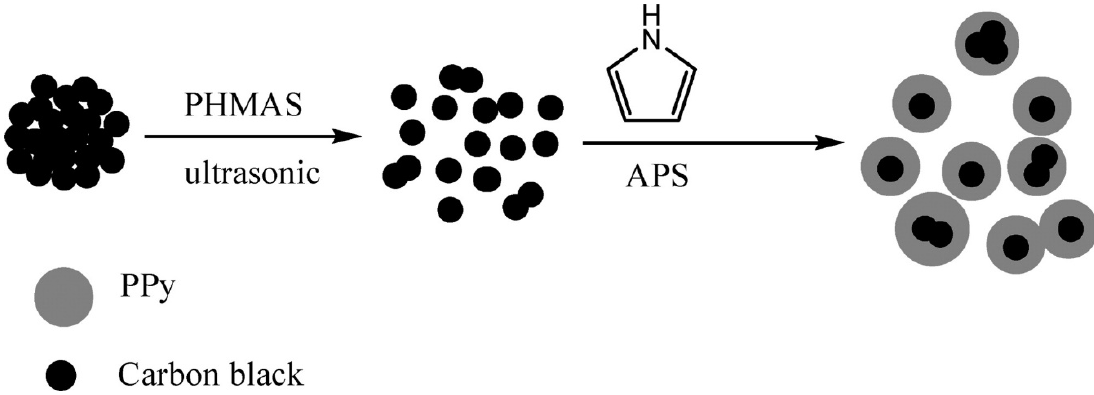
Figure 9. Diagram drawing of the synthesis procedure of the core–shell CB / PPy nanomaterial. Reproduced with permission from [51].